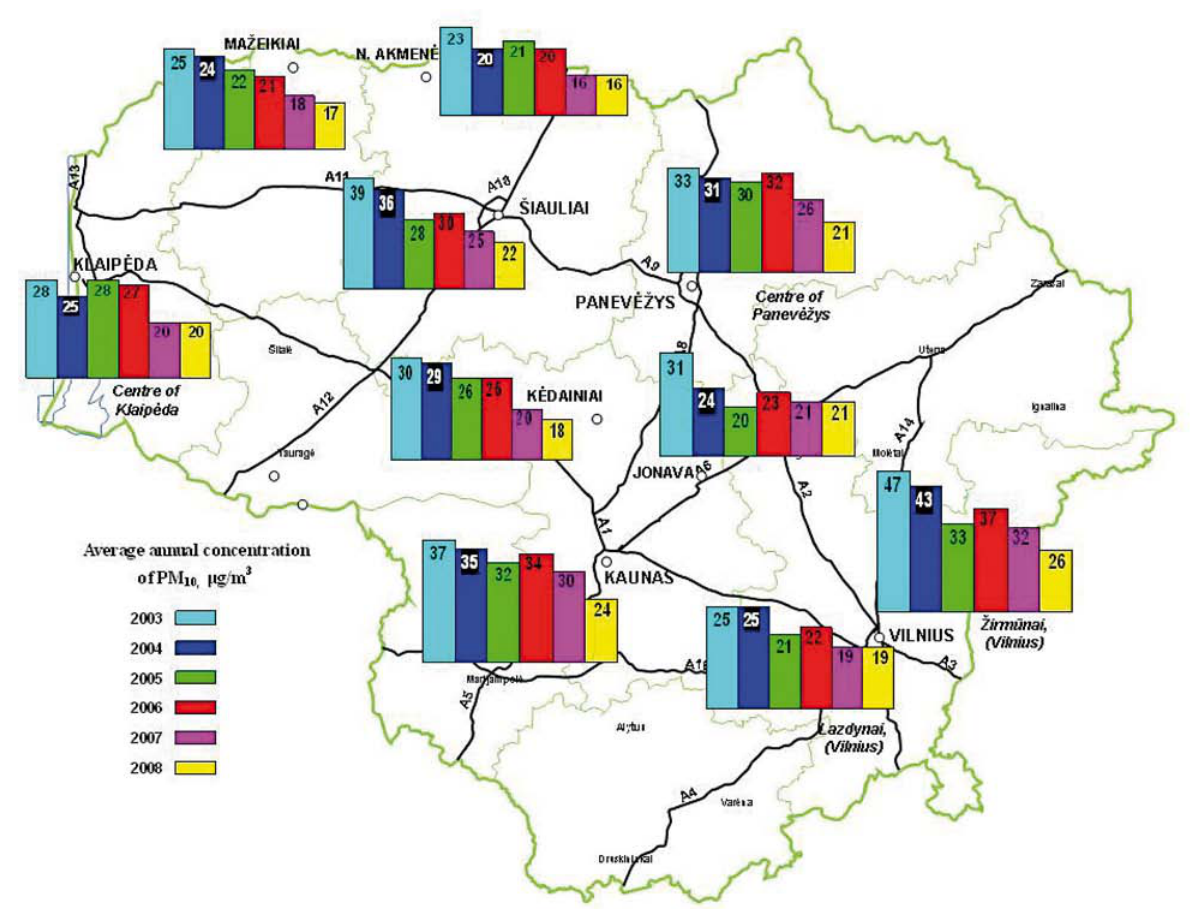
Fig. 1. Average annual concentration of PM 10 in Lithuania (2003–2008) according to 2009 data of Environmental Protection